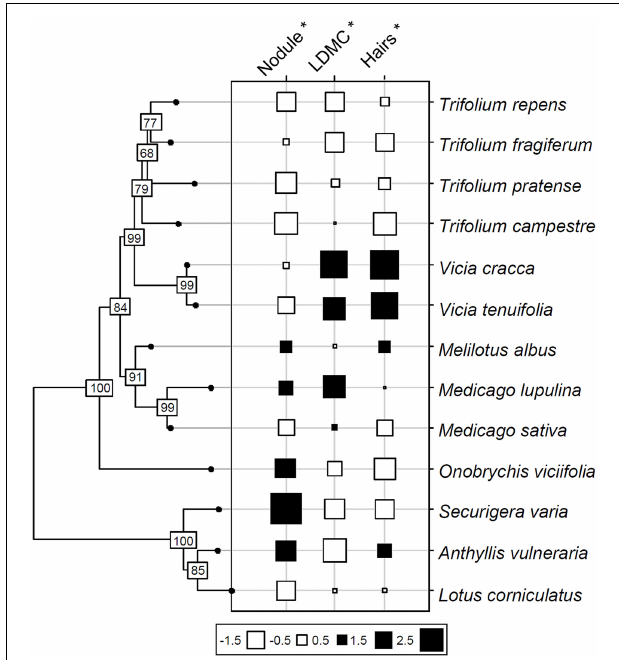
FIGURE 2 | Phylogeny of 13 grassland Fabaceae species based on published sequences of the matK gene (Wojciechowski et al., 2004). Values of three functional traits significantly related to phylogeny are shown at the tips of the phylogeny. Trait values are normalized; values on axis nodes represent bootstrap results. Black squares: high trait values; white squares: low trait values. Nodule biomass per unit of root length (Nodule), leaf dry matter content (LDMC) and root hair length (Hairs) were the traits carrying a significant phylogenetic signal.